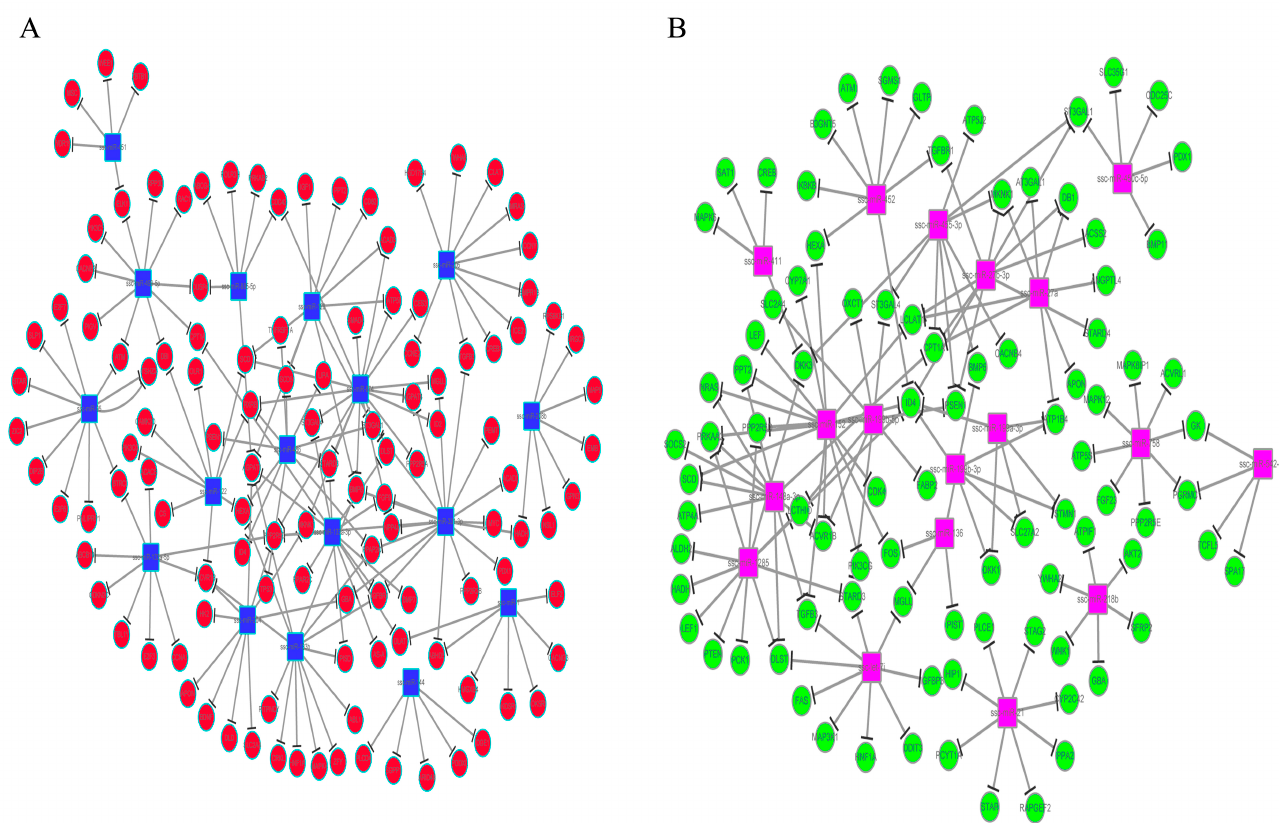
Figure 3. Relationships between the differentially expressed miRNAs and their targeted genes. ( A ) represents the relationships between the up-regulated miRNAs with their targeted genes. ( B ) represents the relationships between the down-regulated miRNAs with their targeted genes. The circular nodes are the targeted genes, while the square nodes represent the differentially expressed miRNAs.